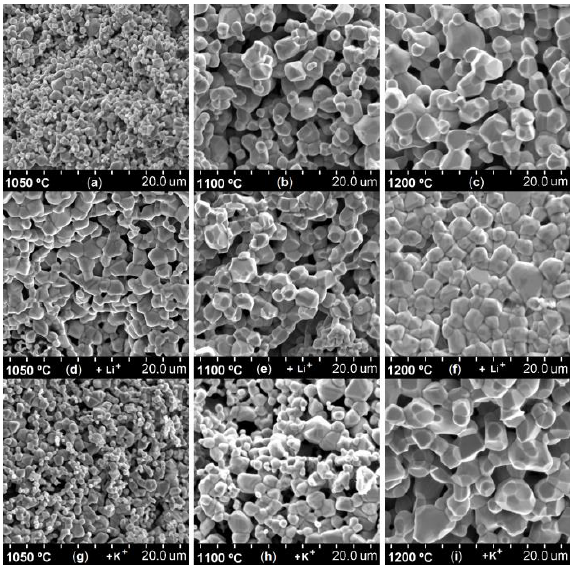
Figure 2 . SEM images of the magnesium-zinc ferrites before and after thermal treatment (t=4h) and cations addition ( a ) T=1000 °C; ( b ) T=1100 °C; ( c ) T=1200 °C; ( d ) 1% Li + , T=1000 °C; ( e ) 1% Li + , T=1100 °C; ( f ) 1% Li + , T=1200 °C;( g ) 1% K + , T=1000 °C; ( h ) 1% K + , T=1100 °C; ( i ) 1% K + , T=1200 °C.